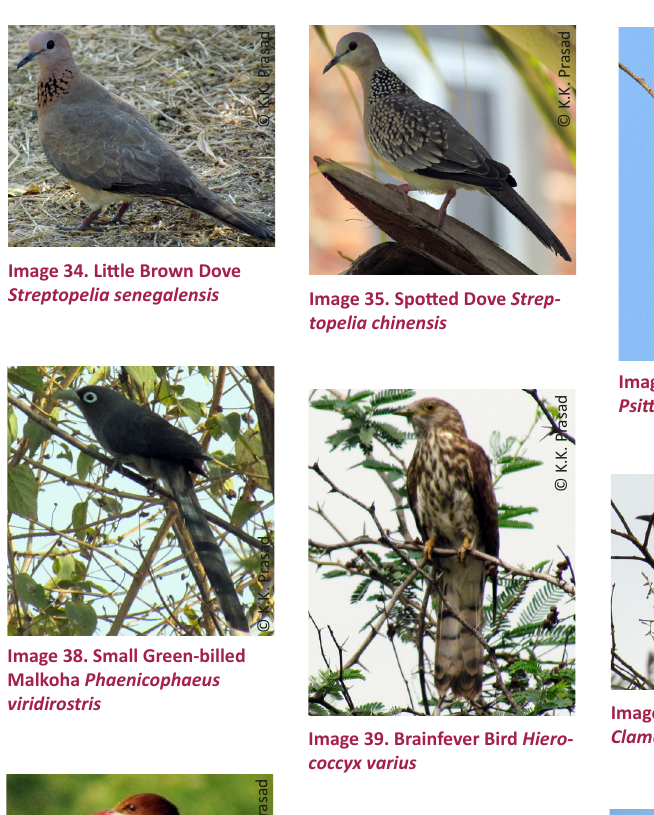
Image 41. Small Blue Kingfisher Alcedo atthis